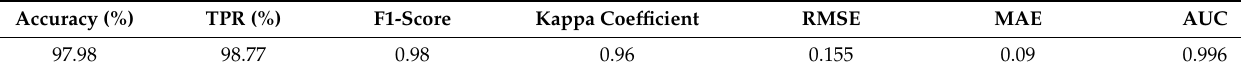
Table 4. Precision evaluation of landslide susceptibility assessment. TPR is the true positive rate that is equal to the recall rate, MAE indicates the mean absolute error, RMSE is the root mean squared error, and AUC is the area under the ROC (receiver operating characteristic curve).